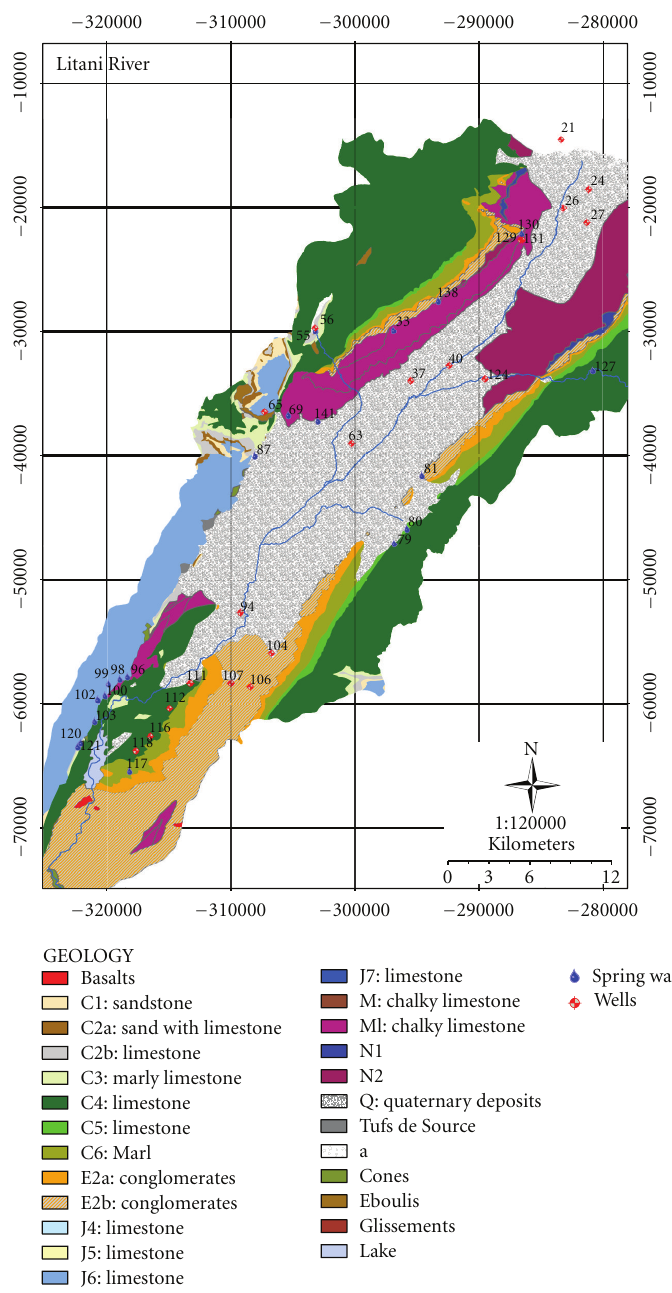
Figure 2: Geological formations of the Upper Litani River Basin